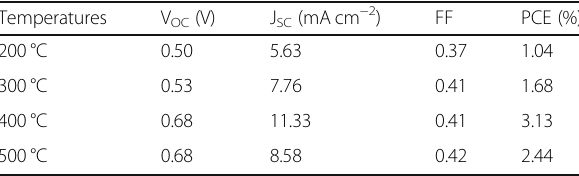
Table 2 Photovoltaic parameters obtained from the J-V curves of QDSSCs using TiO 2 /CIS films annealed at different temperatures as